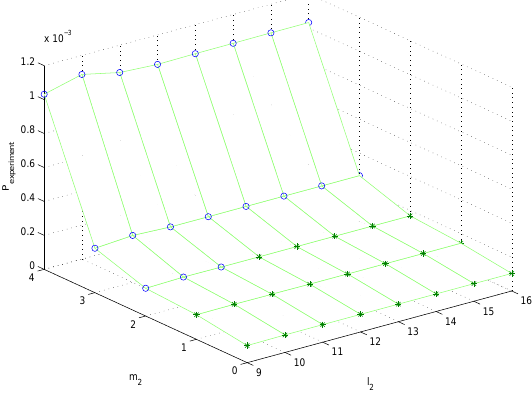
; l ) = (2 ; 9) (o: S ≤ S 1 1